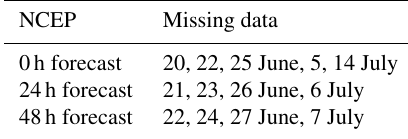
Table 1. Missing data for the NCEP model runs. (Data are not avail- able from the TIGGE